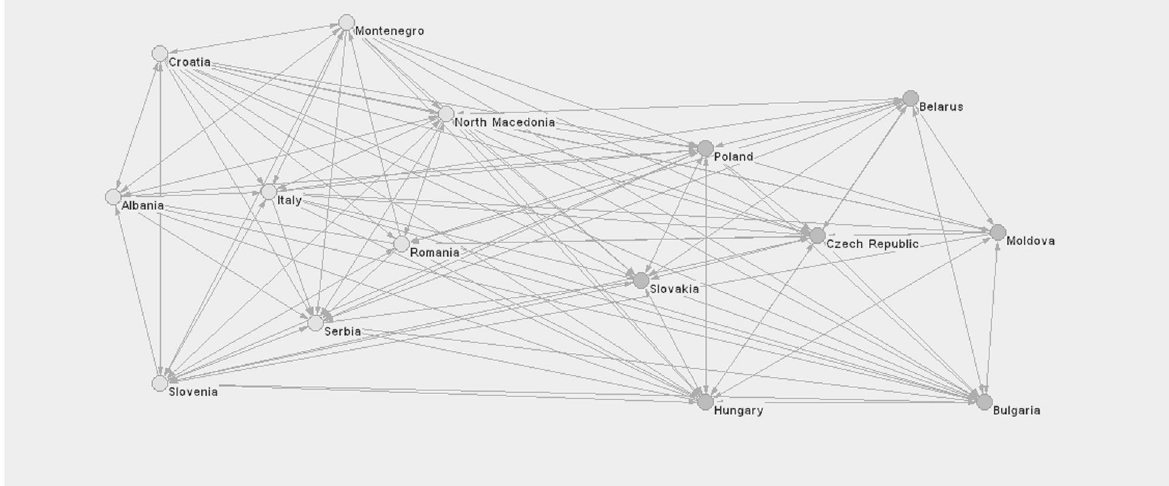
Fig. 1 Current networks of international scienti fi c cooperation among CEI Member States. Two subgroups of countries with denser in-group ties are detected. The two subgroups are represented by dots of lighter and darker grey,